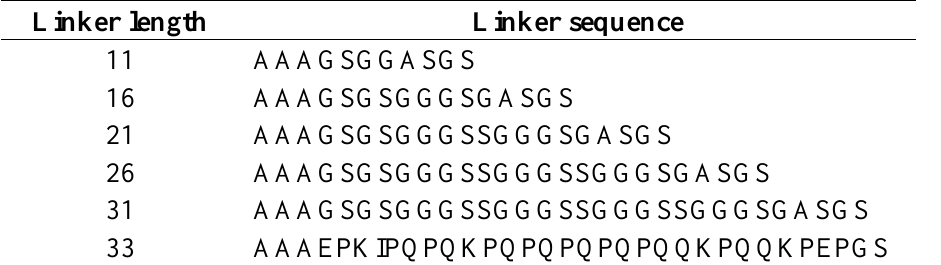
Table 2. Linker lengths and